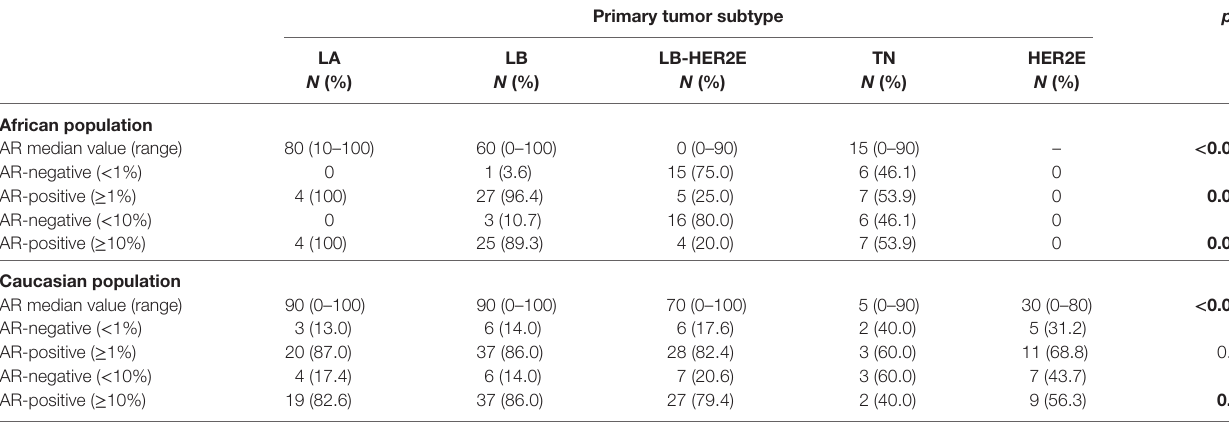
TaBle 5 | Androgen receptor (AR) distribution in the different tumor subtypes of African and Caucasian populations.